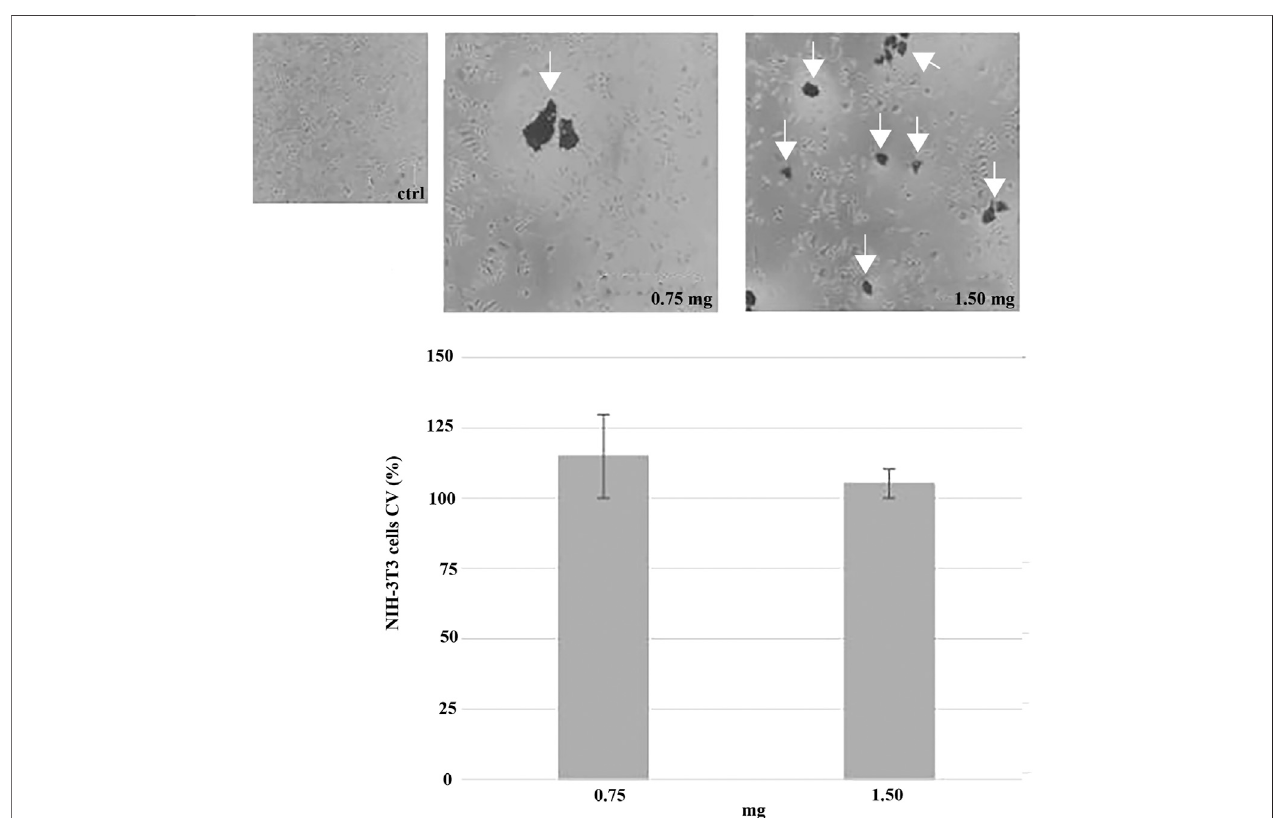
FIGURE10| CytotoxicityresultsforsampleGP-MgO-rich: (A) RepresentativecellularmorphologyimagesofNIH-3T3(Ctrl (cid:1) UntreatedNIH-3T3cells); (B) NIH-3T3 cell viability (CV, %).